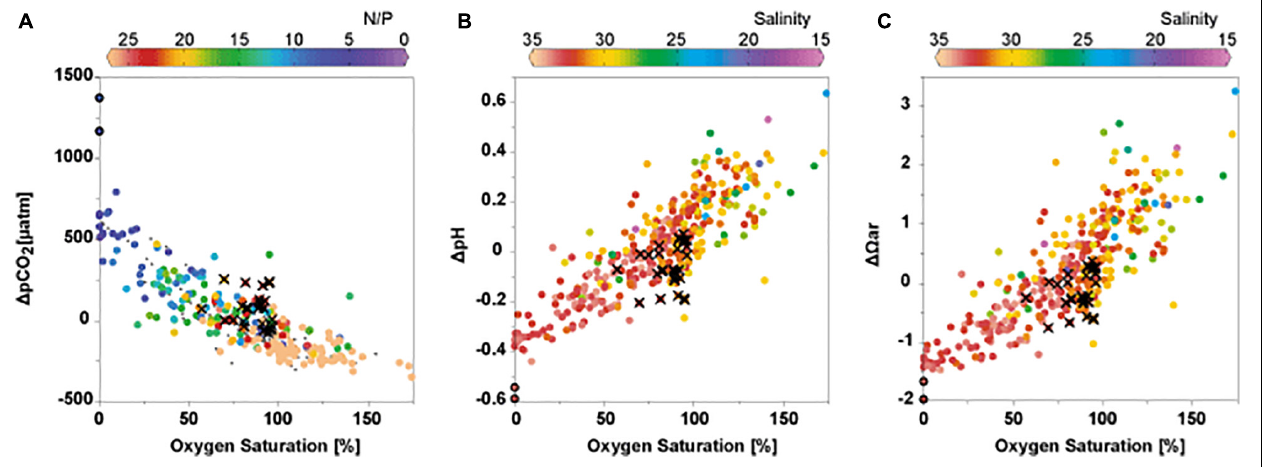
FIGURE 6 | (A) (cid:49) pCO 2 , (B) (cid:49) pH, and (C) (cid:49)(cid:127) plotted against oxygen saturation %. Color indicates ratio of DIN (nitrate + nitrite + ammonia) over phosphate in (A) , and S in (B,C) . Gray dots are data after November 2015, when nutrient data are not available. Crosses represent data for samples collected in December. Black circles demonstrate the aragonite undersaturations and anoxic waters observed in August 2013 and July